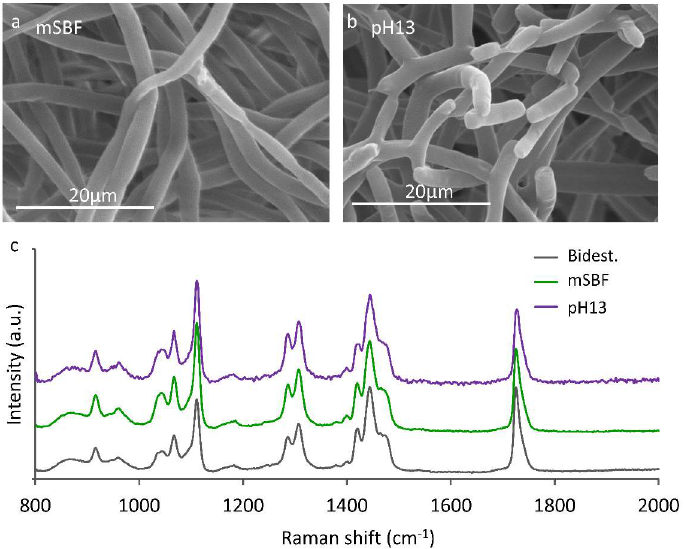
Figure 9. SEM pictures of PCL fiber mats: ( a ) after immersion in mSBF; ( b ) and NaOH-solution. ( c ) Raman spectra of PCL electrospun fiber mats after immersion in dist. water, mSBF, or NaOH-solution (pH 13).